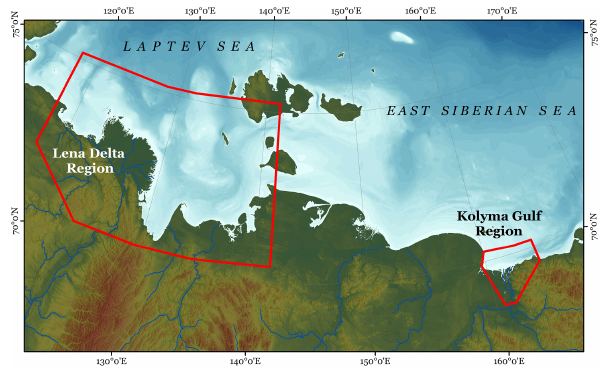
Figure 1. Study areas (red frames) of the Lena Delta and Kolyma Gulf regions. The background image is the IBCAO v4 200m spatial resolution raster map (Jakobsson et al.,